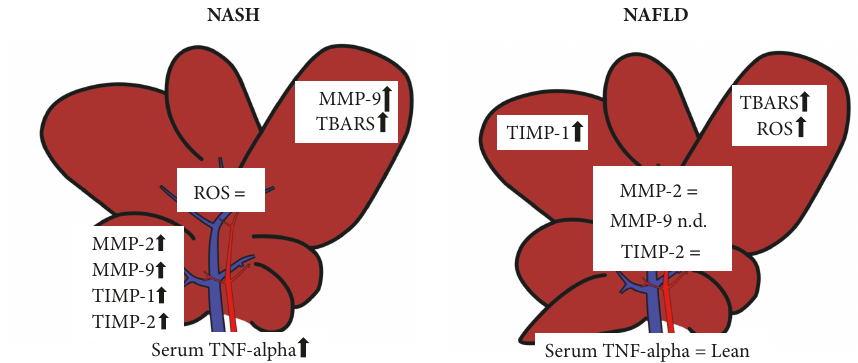
Figure 8: Schematic representation of liver lobes heterogeneity in NASH and NAFLD models (MMPs, matrix metalloproteinases; TIMPs, tissue inhibitors of metalloproteinase ROS, reactive oxygen species; TBARS, thiobarbituric acid-reactive substances).